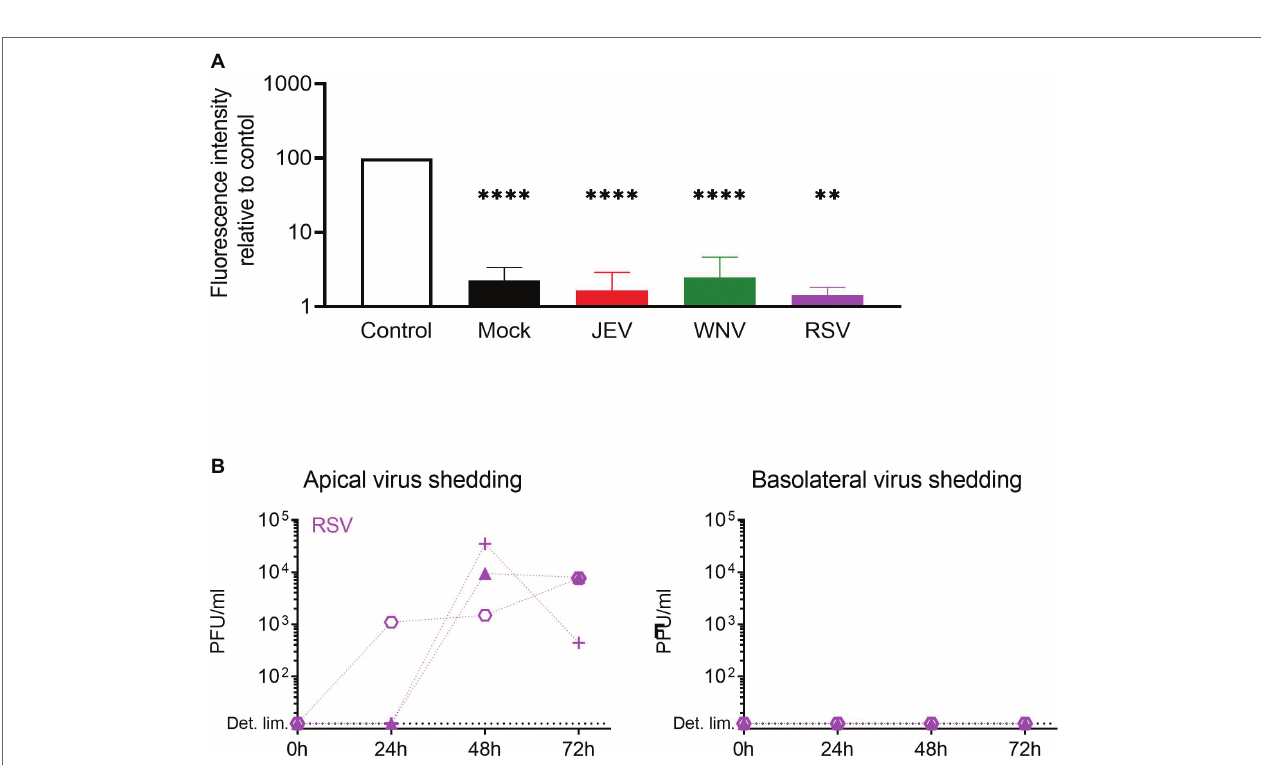
FIGURE 5 | Epithelial barrier function is maintained upon flavivirus infection. (A) Relative fluorescence intensity in the basolateral chamber was measured after apical application for 4 h of FD4 on inserts 72 h p.i. with JEV, WNV, and RSV. Values are expressed as % of fluorescence relative to control (empty insert). Data are presented as mean and SD of 3–4 healthy donors. (B) Apical and basolateral infectious virus shedding up to 72 h p.i. with RSV measured by PFU assay and expressed in PFU/ml in NECs infected at a MOI of 1 PFU/cell. Each symbol represents an independent donor. Statistical analysis was done in comparison to control; ** p < 0.01; **** p <